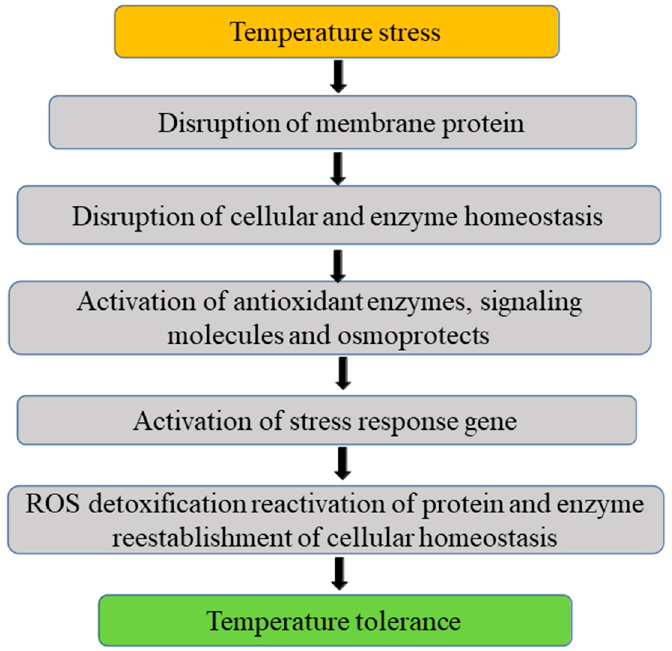
Figure 3. The overview of cyanobacterial response after varying temperature conditions.